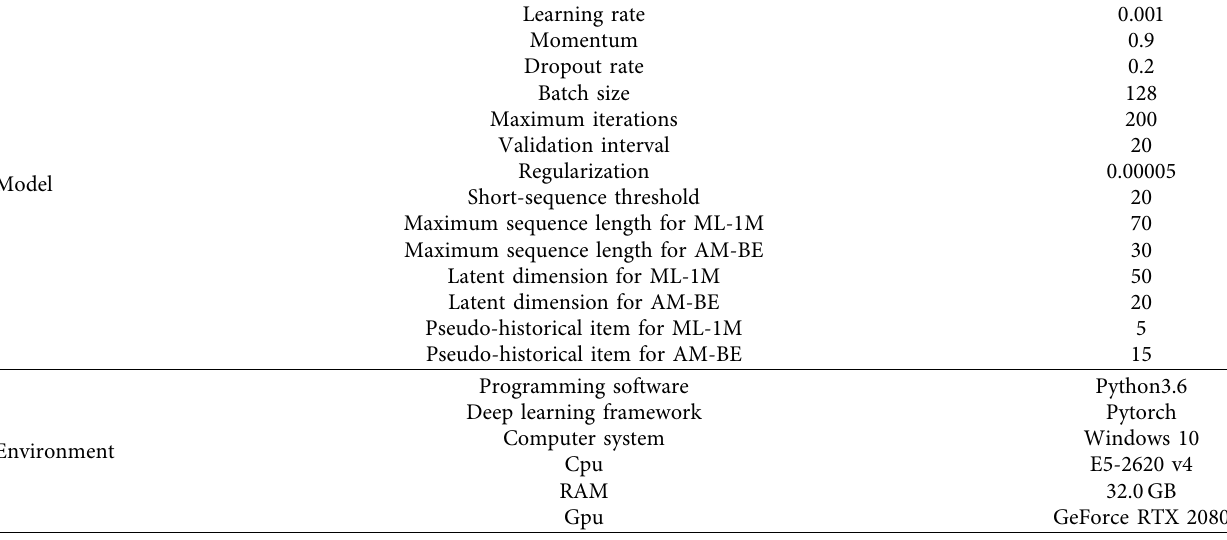
Table 2: The parameters of the proposed model and the experimental environment.